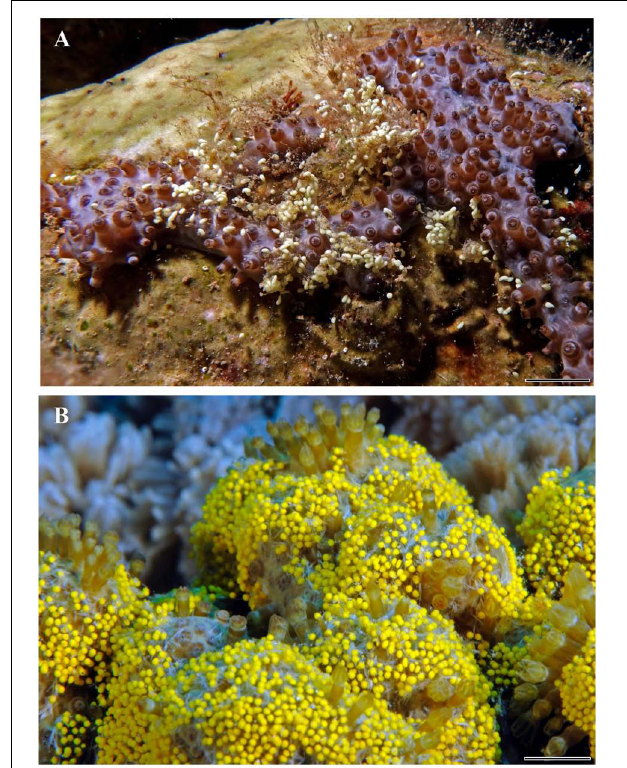
FIGURE 1 | Surface-brooding of Rhytisma fulvum fulvum : ( A) mesophotic gray morph and (B) shallow-water yellow color morph. Both images feature brooded planula-larvae entangled in a mucus layer during surface-brooding. Scale bars = 0.5 cm. (Photo (B) courtesy of Gil